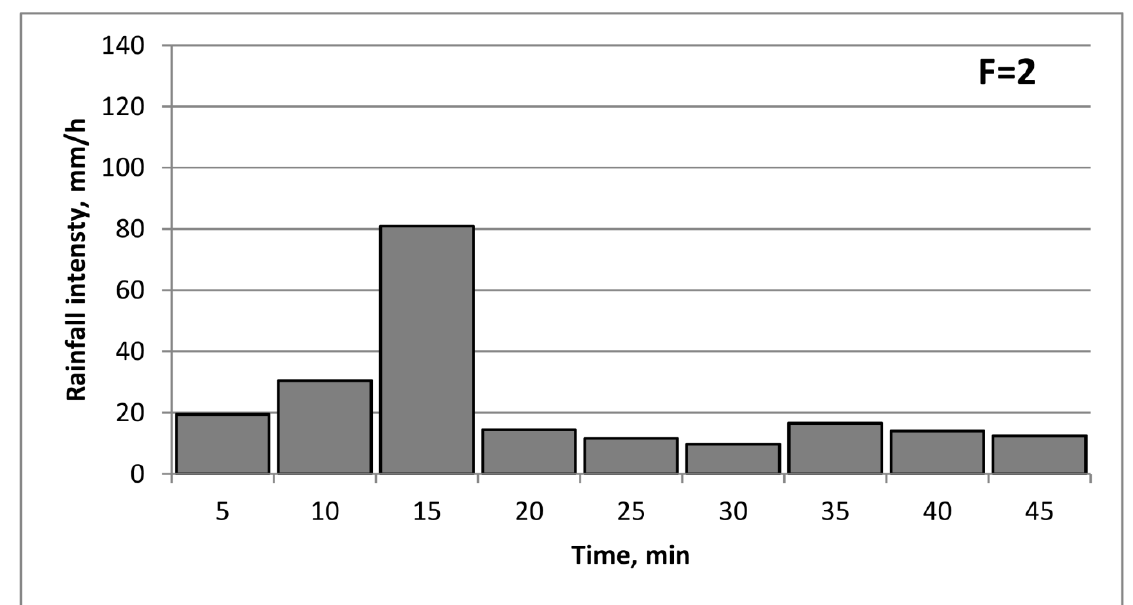
Figure 6. Rainfall scheme of Euler type II model—duration 45 min. (frequency of occurrence of modelled rainfall F = 2) [40,41].